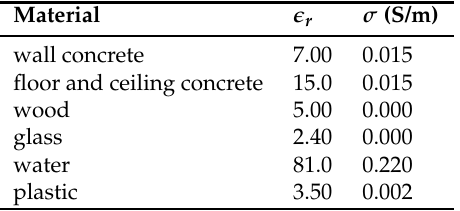
Figure 4. Wireless Insite simulation model of a real retail store (different views). Table 3. Material electrical properties of a retail store simulation